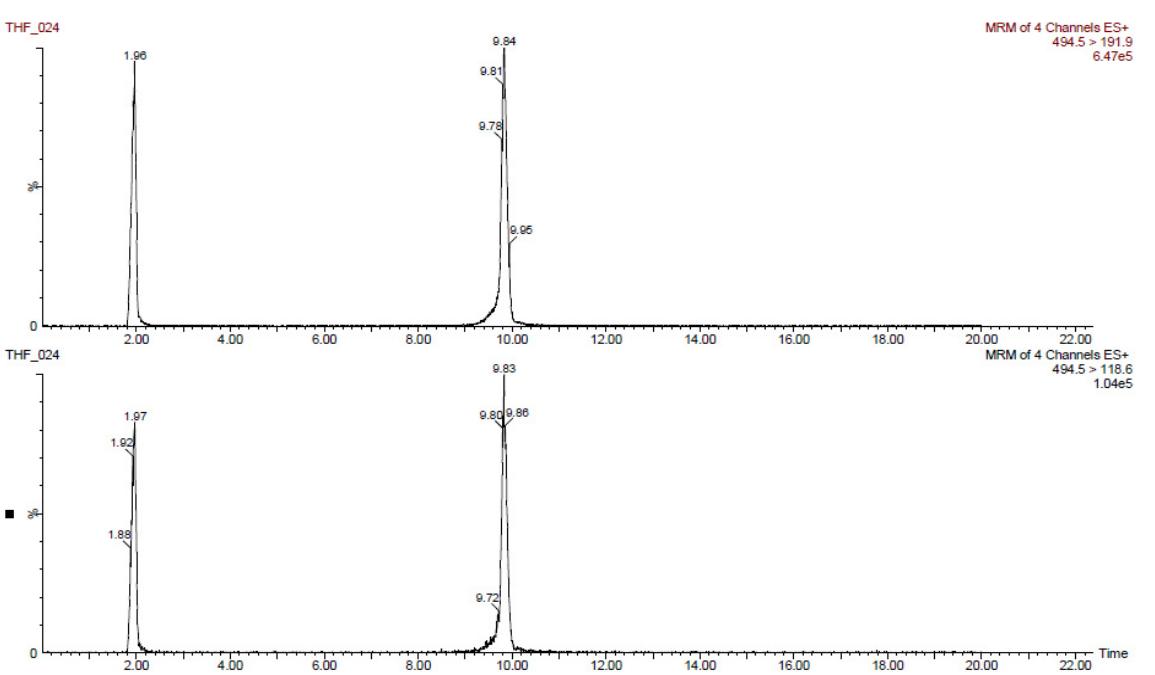
Figure A4. Chromatogram of the reference solution with a concentration of 0.5 μ g tiamulin/mL in the matrix.